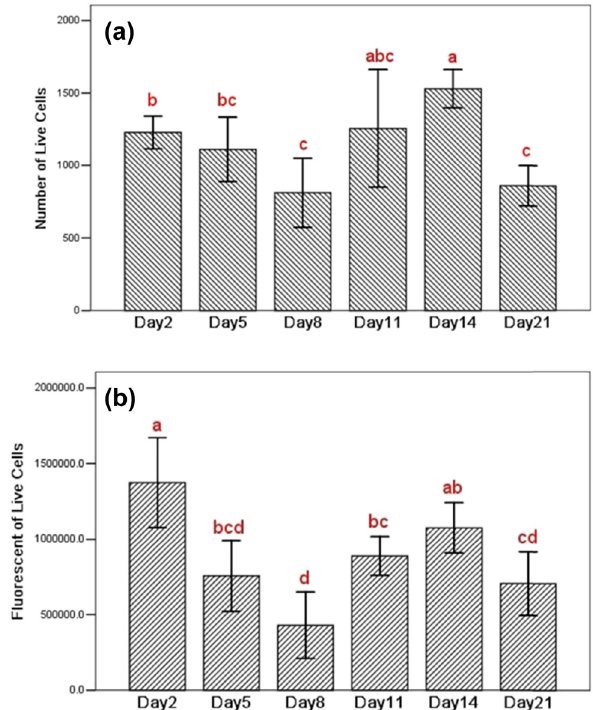
Figure 6: ( a ) Comparisons of the number of live ( N L ) A - cells cultured in vitro at di ff erent times ( n = 8, X ± SD ) . ( b ) Comparisons of the fl uorescence intensity of live ( F ) A - cells cultured in vitro at di ff erent L times. The di ff erence between groups with di ff erent letters ( a, b, c ) was statistically signi fi cant ( P < 0.05 ) . Groups with the same letter were not signi fi cantly di ff erent ( P > 0.05 )